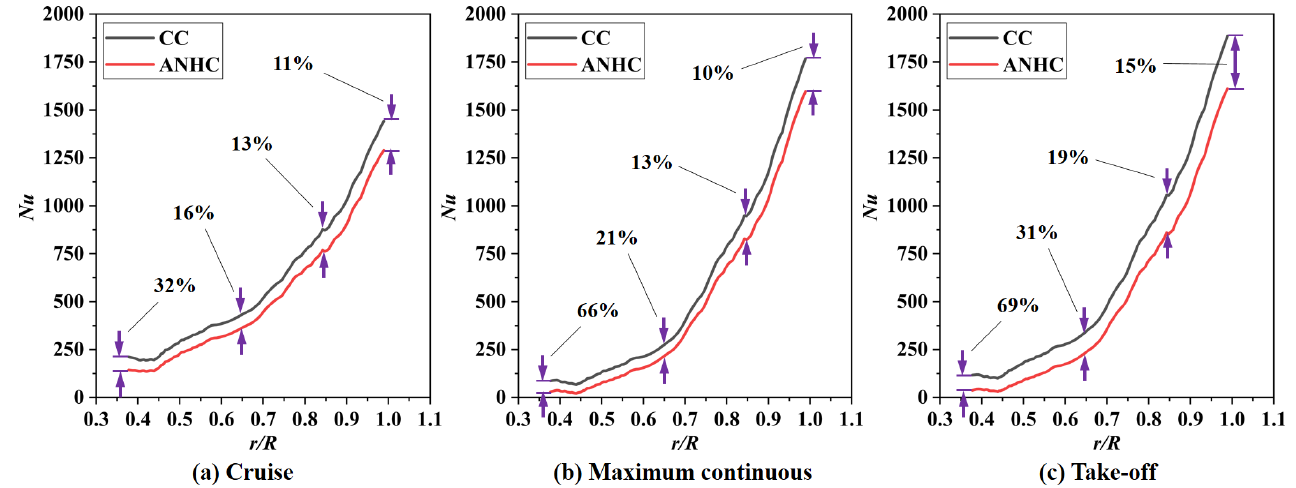
Figure 19. Nusselt numbers under CC and ANHC.